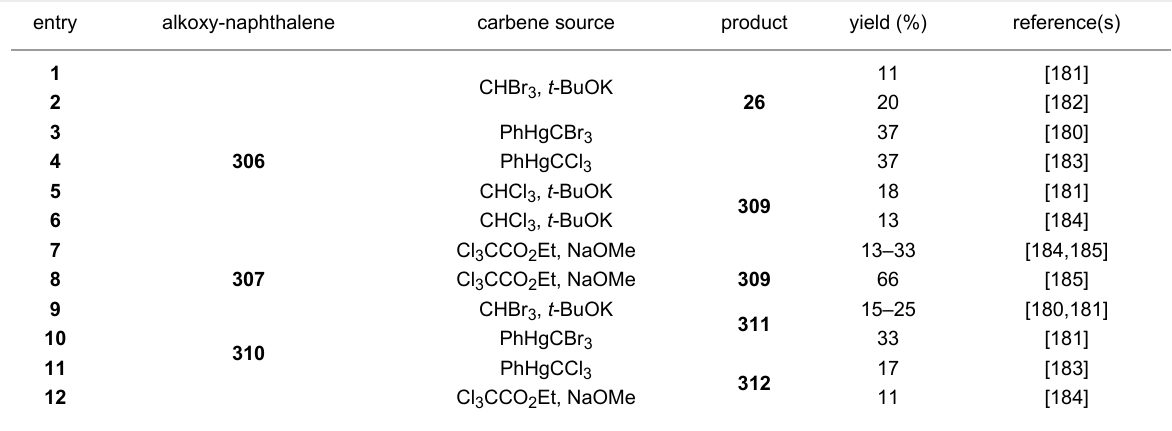
Table 2: Synthesis of some mono-halobenzotropones via carbene